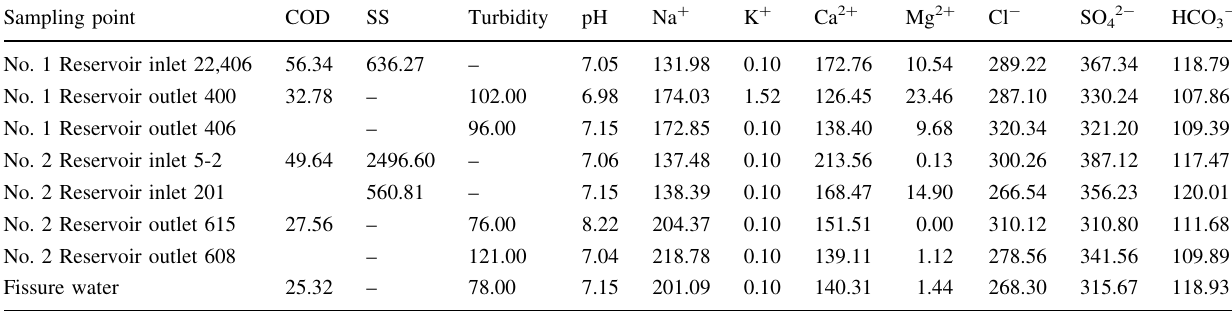
Table 1 Chemical analysis of coal mine groundwater reservoir (mg/L) Sampling